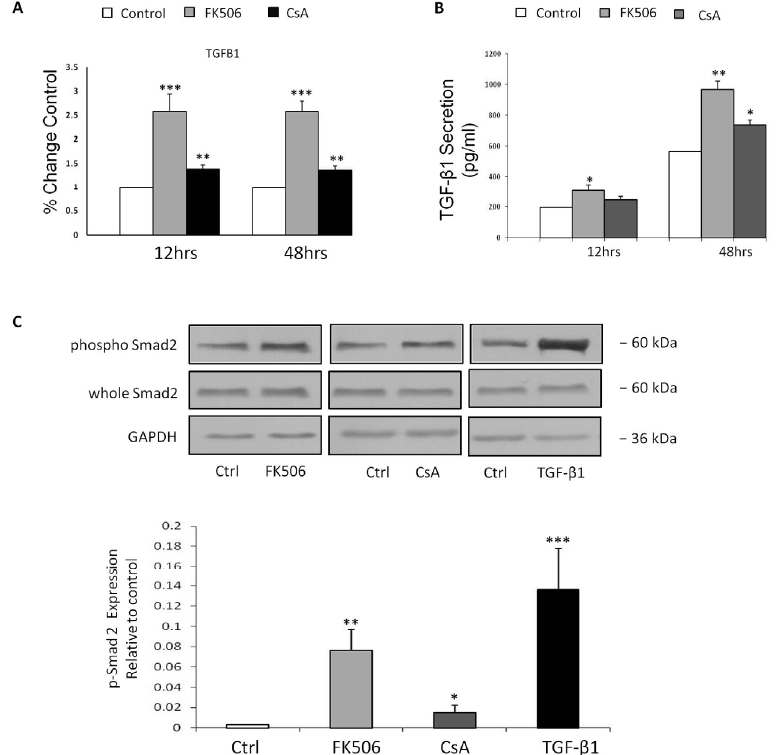
Figure 4. Effect of FK506 treatment on HK ‐ 2 TGF β‐ 1 mRNA levels, secretion levels and whole cell levels of phosphorylated Smad ‐ 2. HK ‐ 2 cells were cultured in 6 ‐ well plates and treated with control medium or medium containing 5 μ M FK506 or 5 μ M CsA for the indicated time periods. ( A ) RNA was isolated and cDNA synthesised. Real time RT ‐ PCR was then carried out on the cDNA using primers specific to TGF ‐β 1. 18S RNA was used as a total RNA control throughout. Data is expressed as a relative change in mRNA levels relative to time ‐ matched control ± SEM ( n = 4): * p < 0.05, ** p < 0.01 vs. time ‐ matched vehicle treated control cells; ( B ) Cell supernatants were harvested at the indicated time ‐ points and TGF ‐β 1 levels were detected using a TGF ‐β 1 ELISA (R&D Systems). Data is expressed as pg/mL TGF ‐β 1 and represents the mean concentration ± SEM ( n = 4): * p < 0.05, ** p < 0.01 vs. time ‐ matched vehicle treated control cells; ( C ) Whole cell protein was extracted at 48 h with RIPA buffer. Equal amounts of protein were separated by SDS ‐ PAGE electrophoresis, transferred to nitrocellulose and indirectly probed for phospho ‐ Smad2. Whole cell Smad2 was used as a loading control. A representative blot is shown from three independent experiments.